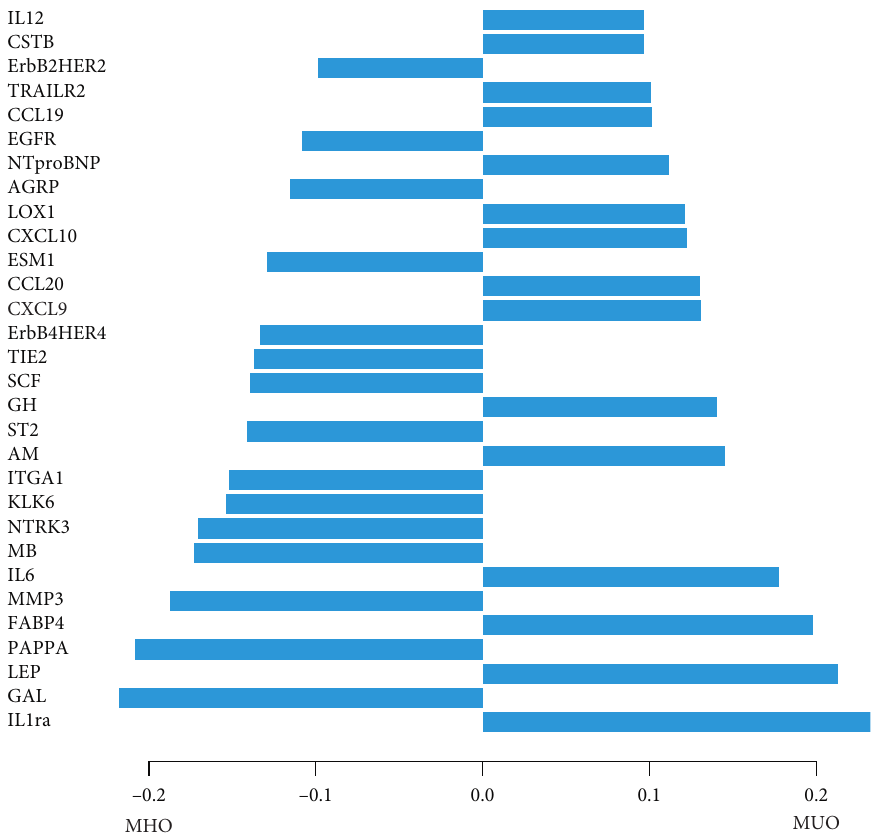
Figure 5: Correlation between biomarker principal components and cardiometabolic risk factors. Correlations between cardiometabolic risk factors and lipid principal component 2 (pl2) and protein principal component 5 (pp5) are expressed as partial Spearman’s correlation coefficients, adjusted for age and sex. AHT: antihypertensive treatment; CRP: C-reactive protein; DBP: diastolic blood pressure; SBP: systolic blood pressure; HbA1c: glycated haemoglobin; HOMA-IR: homeostatic model assessment for insulin